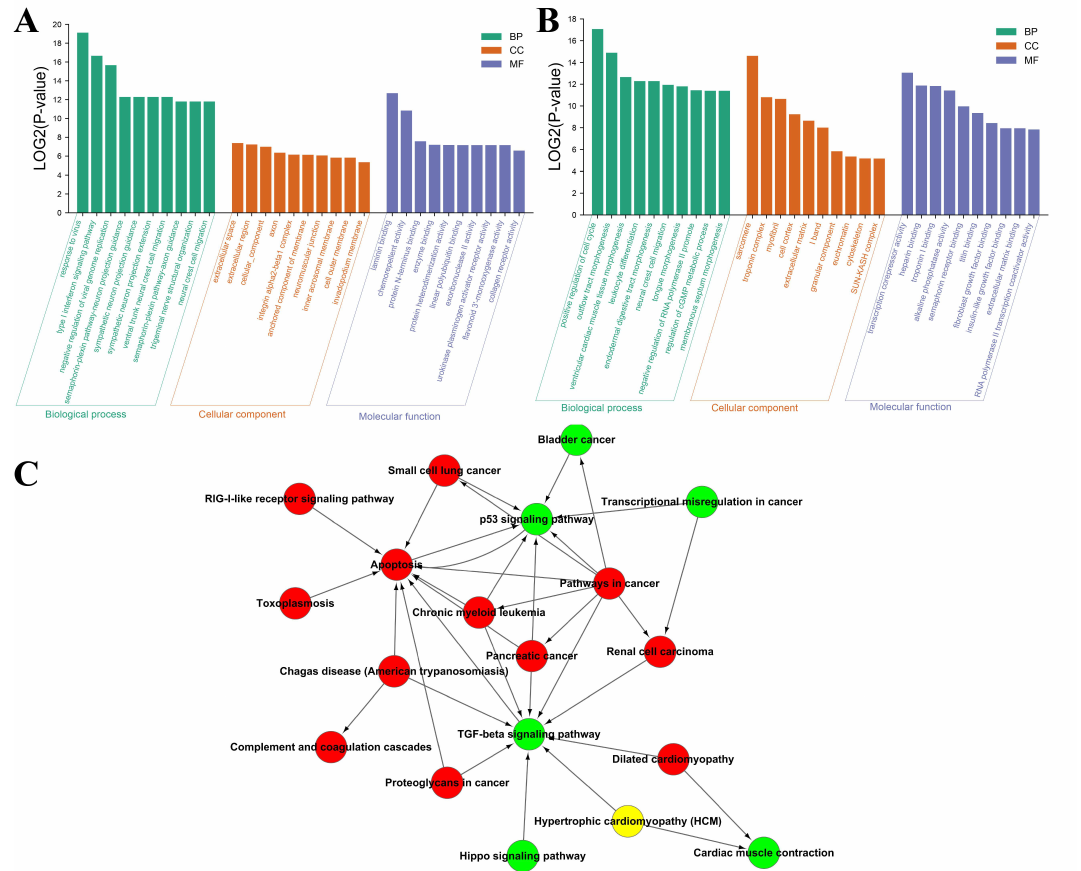
Figure 8. Enrichment analysis of DEGs in transcriptome. ( A ) GO enrichment of up-regulated DEGs in three major GO categories, including biological process (BP), molecular function (MF), and cell composition (CC). ( B ) GO enrichment of down-regulated DEGs. ( C ) Pathway network of KEGG enrichment of DEGs. The red circles represent the up-regulated pathways, the green circles represent the down-regulated pathways, and the yellow circle represents non-significantly difference